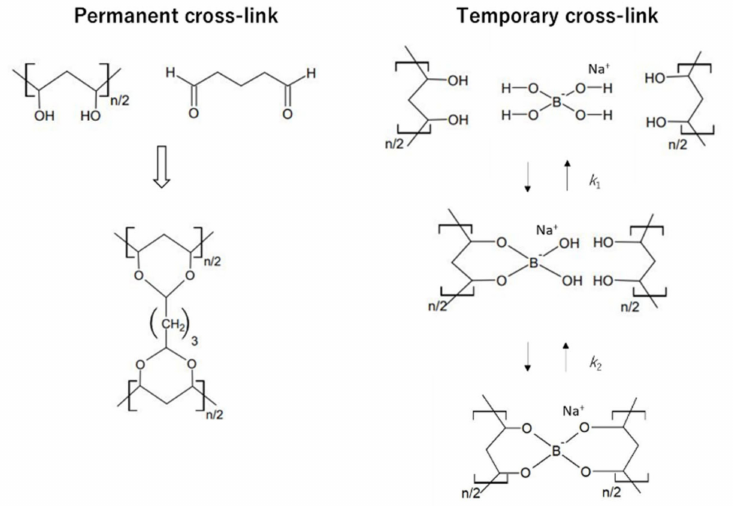
Figure 1. Chemical structures of the permanent cross-link formed by glutaraldehyde and temporary cross-link generated by a tetrahydroxy borate